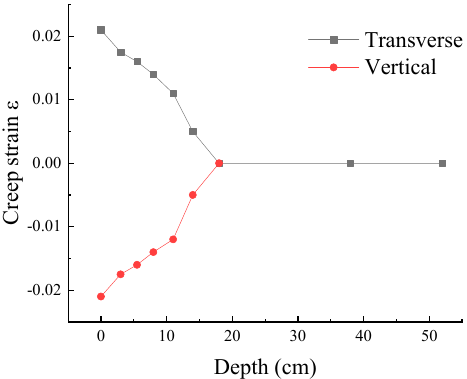
Figure 10. Distribution of creep strain at different depths under the center of the leftmost wheel.